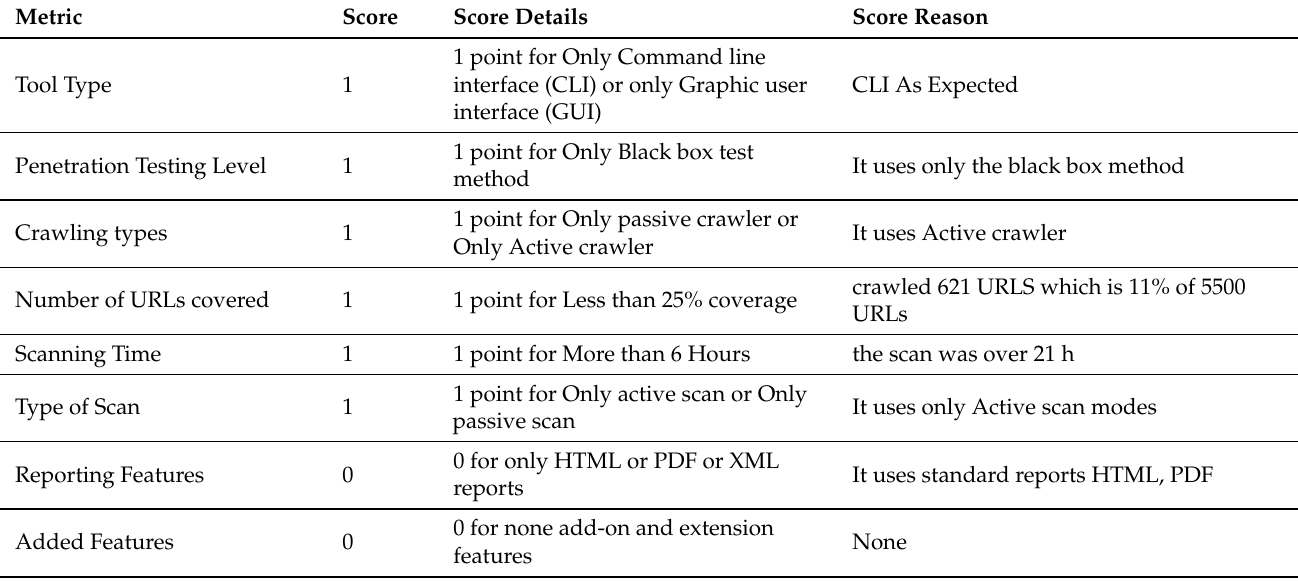
Table A6. Results of benchmarking Wapiti3 using our framework in